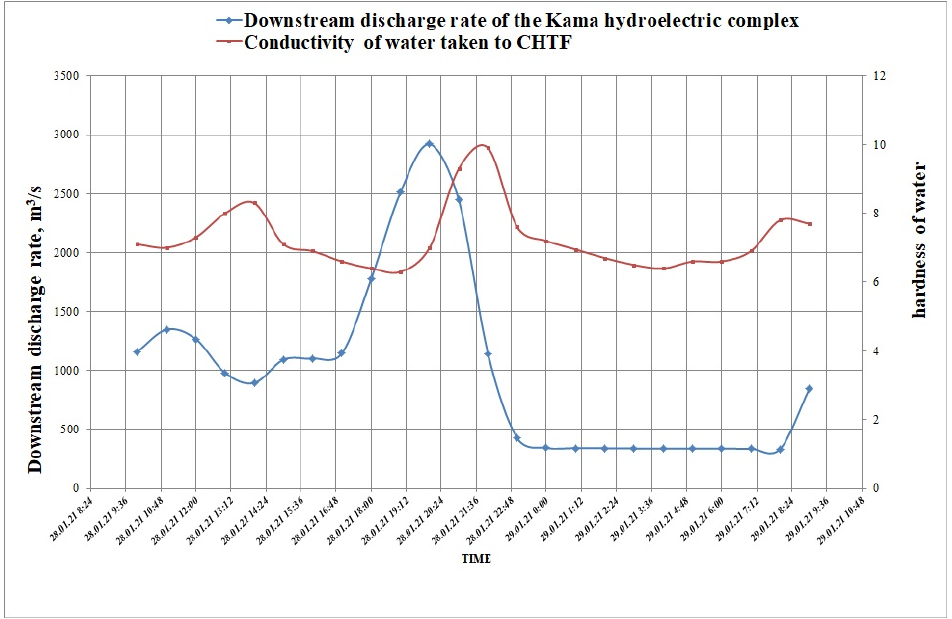
Figure 11. Superimposed chronological graphs of water discharge into the lower pool of the Kamskaya HPS and measured water hardness in the Chusvskoy water intake area.